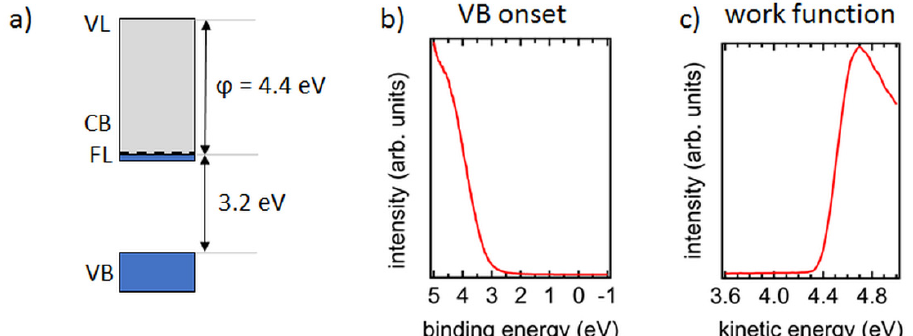
Figure 7. ( a ) Schematic IZO band diagram, ( b ) valence band onset, and ( c ) secondary electron cutoff (SECO) obtained from UPS measurements.